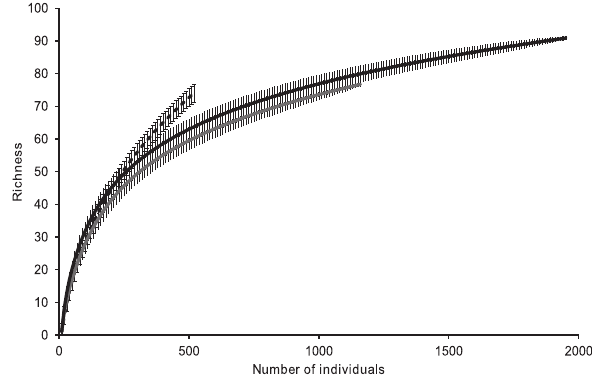
Figure 3. Rarefaction curves with the confidence limits for the three habitats sampled. Solid black line indicates forest, solid gray line indicates edge, and dotted line indicates